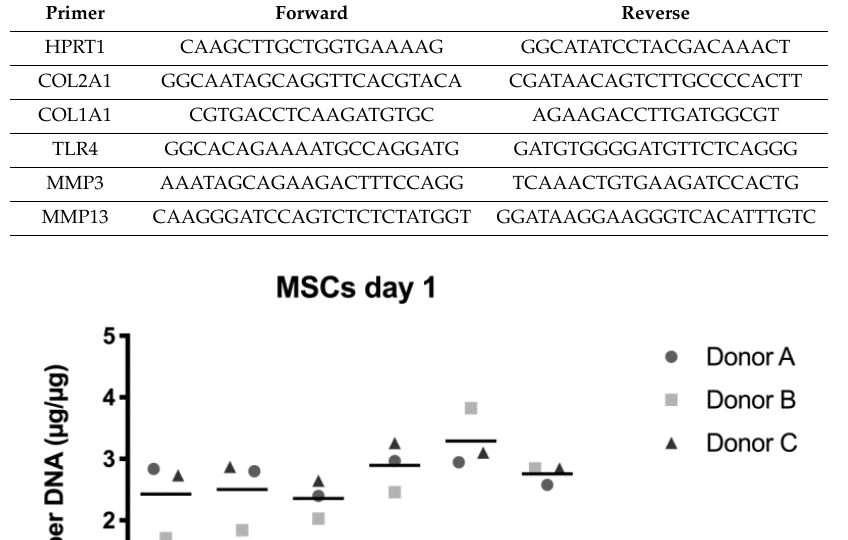
Table A1. Primer sequences used for detection of gene expression in qRT-PCR.